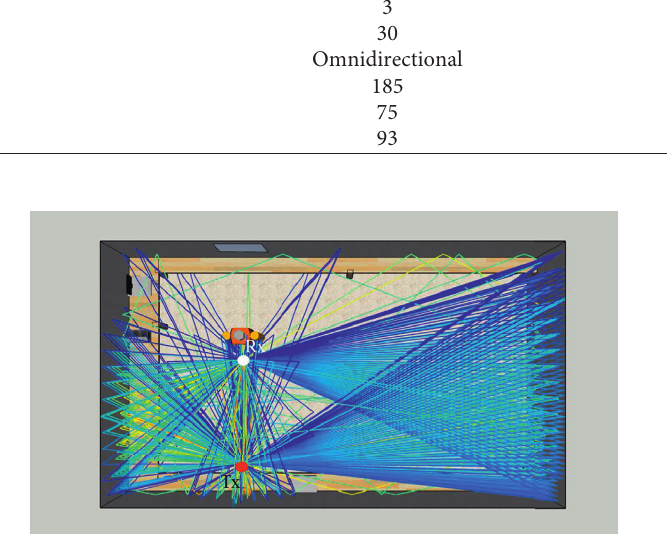
Figure 21: Ray-tracing visualization in front of human